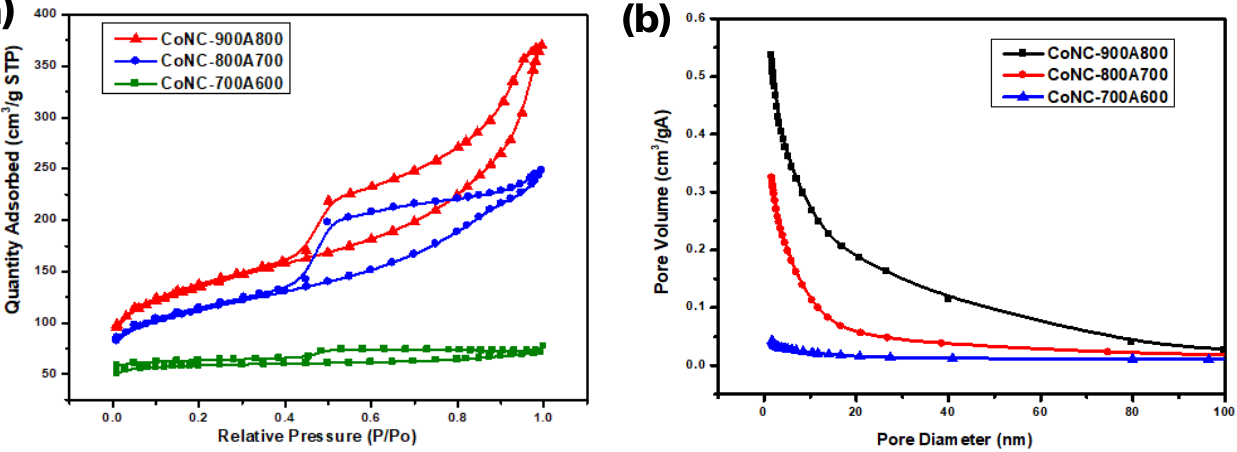
Figure 8. BET analysis of various Co – N – C catalysts. ( a ) N 2 adsorption – desorption isotherms and ( b ) pore size distribution. Table 3. BET surface area and average pore sizes of various Co – N – Cs.